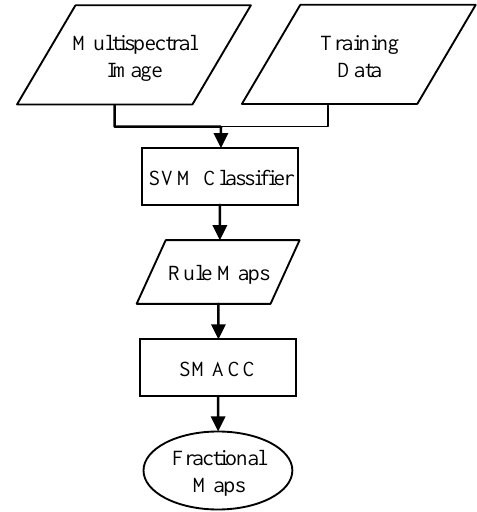
Figure 2. The proposed method for soft